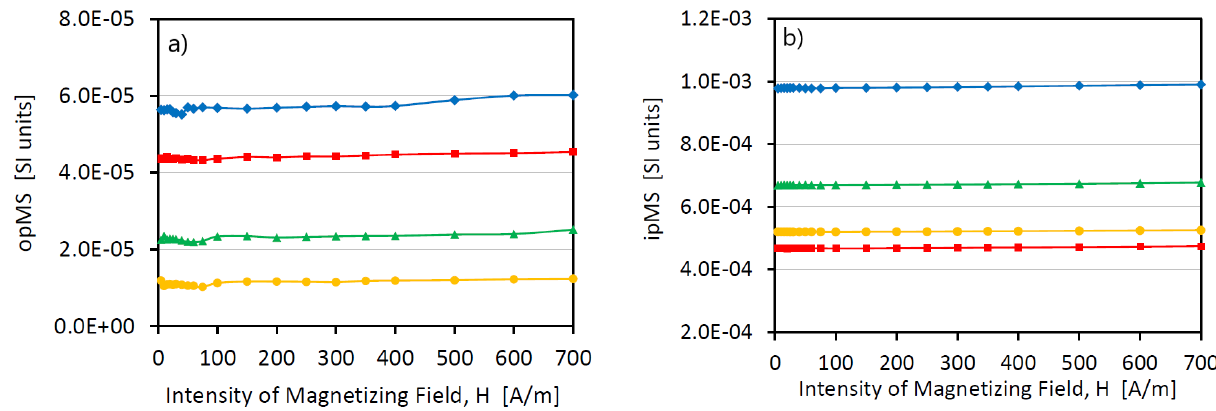
Figure 9. opAMS and ipAMS in loess/palaeosol sequence in Bulhary locality: ( a ) percentage loss of susceptibility ( K FD = 100 ( k 976 − k 15,616 )/ k 976 ) vs. ipMS, ( b ) P - T plot, ( c ) opAMS lineations (Max) and opAMS foliation poles (Min), ( d ) ipAMS lineations (Max) and ipAMS foliation poles (Min) in equal- area projection on lower hemisphere. Adapted from